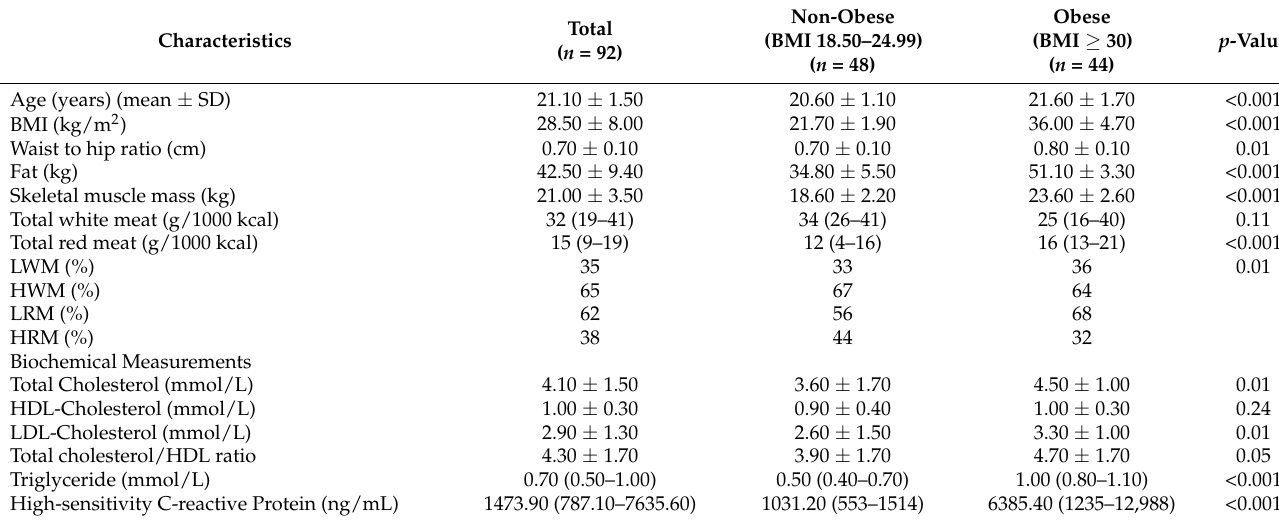
Table 1. Characteristics of obese and non-obese groups, n = 92 1